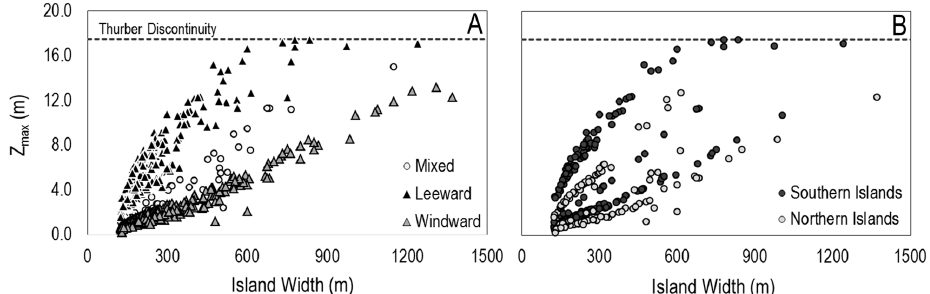
Figure 6. ( A ) Lens thickness ( Z max ) for the 680 islands in the Republic of Marshall Islands, graphed according to island width and by position of each island on the atoll (windward, leeward, mixed); ( B ) Lens thickness ( Z max ) for the islands located in the north and south of the RMI geographic region.